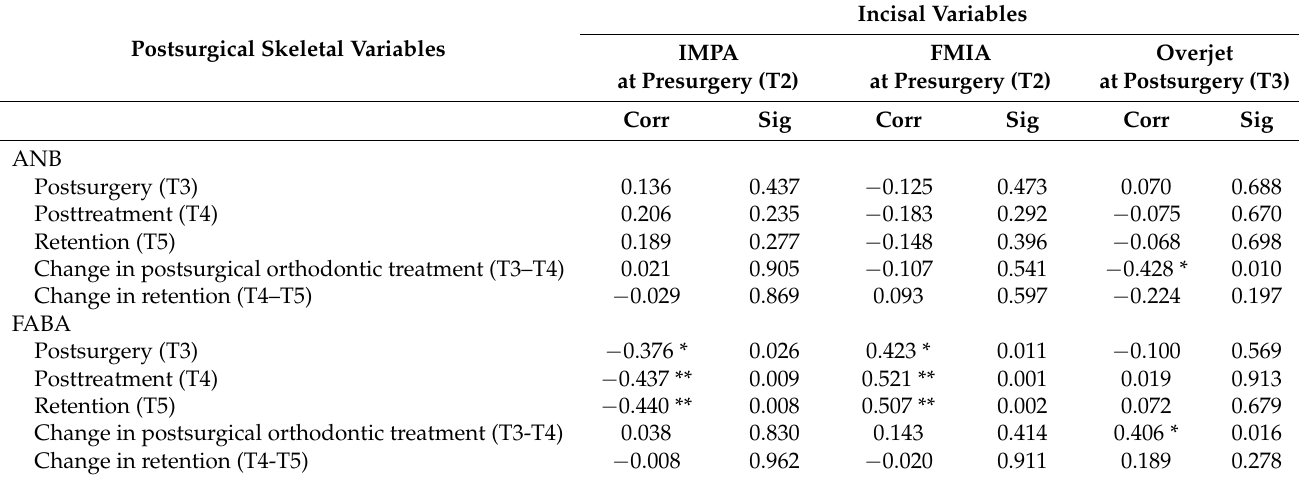
Table 5. Relationships between incisal and postsurgical skeletal